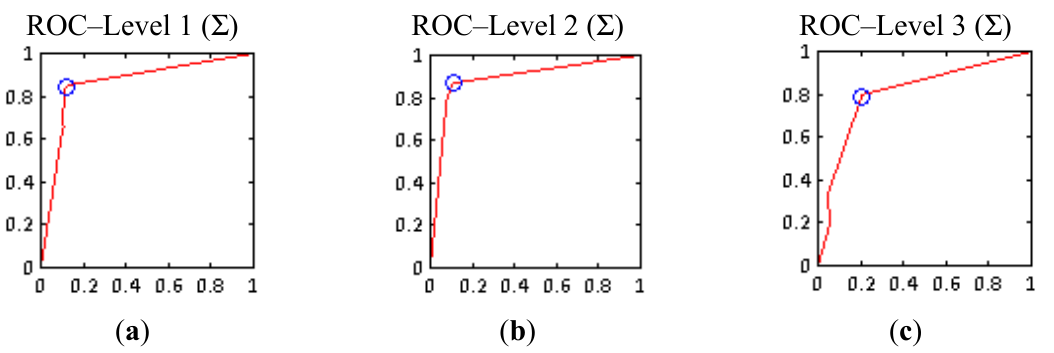
Figure 13. Summative method ( Σ ) ROC curves ( a ) Level 1; ( b ) Level 2; ( c ) Level